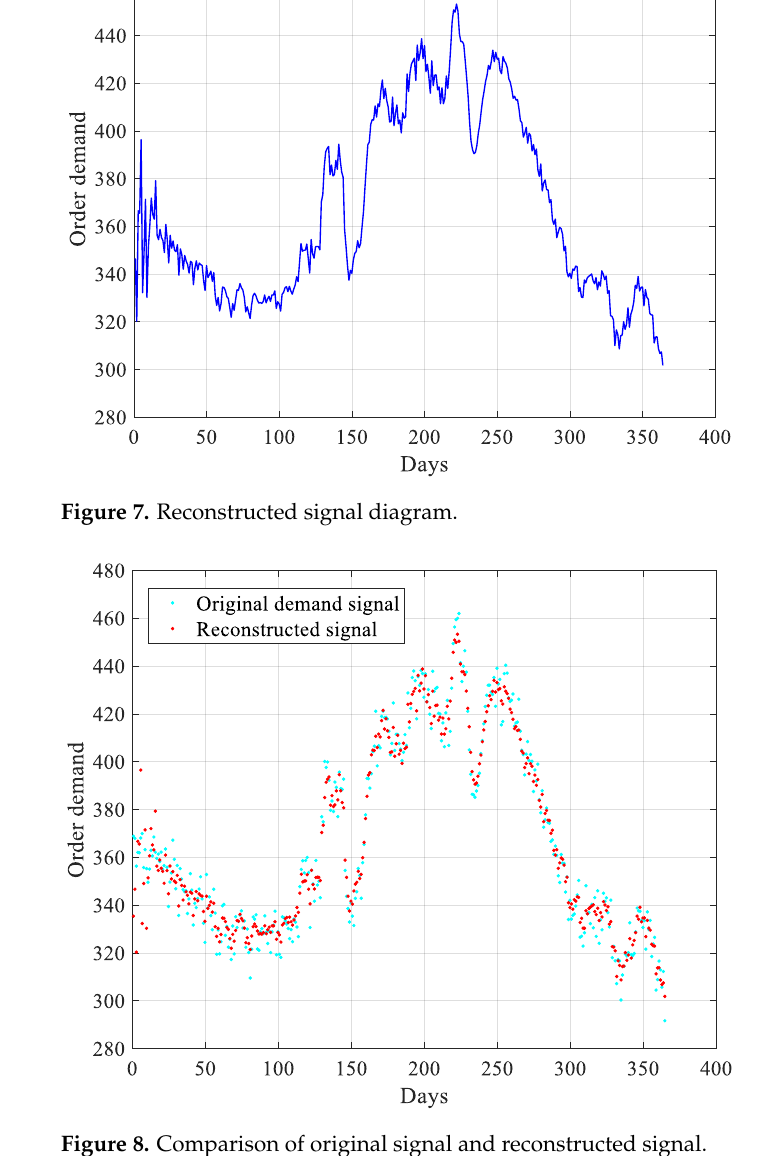
Figure 8. Comparison of original signal and reconstructed signal .